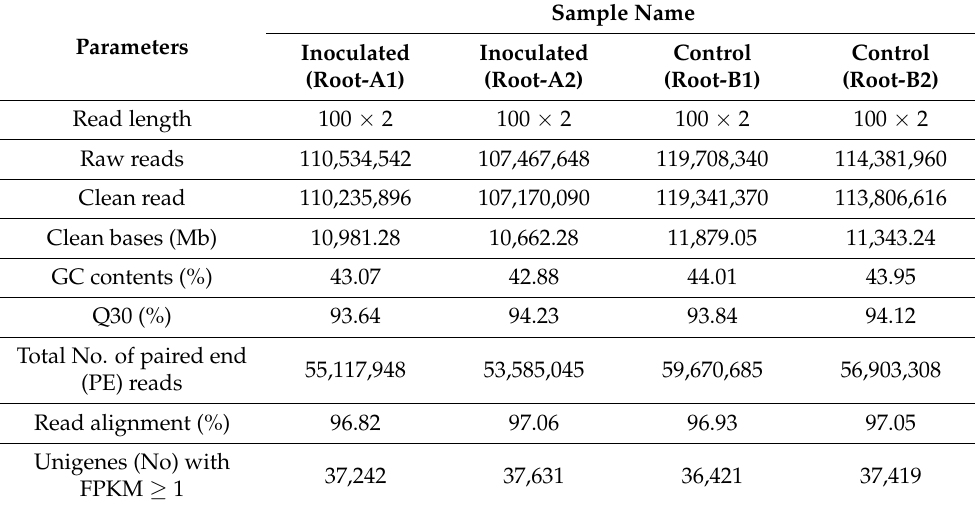
Table 1. Summary of RNA-seq data in four lentil root samples (control and